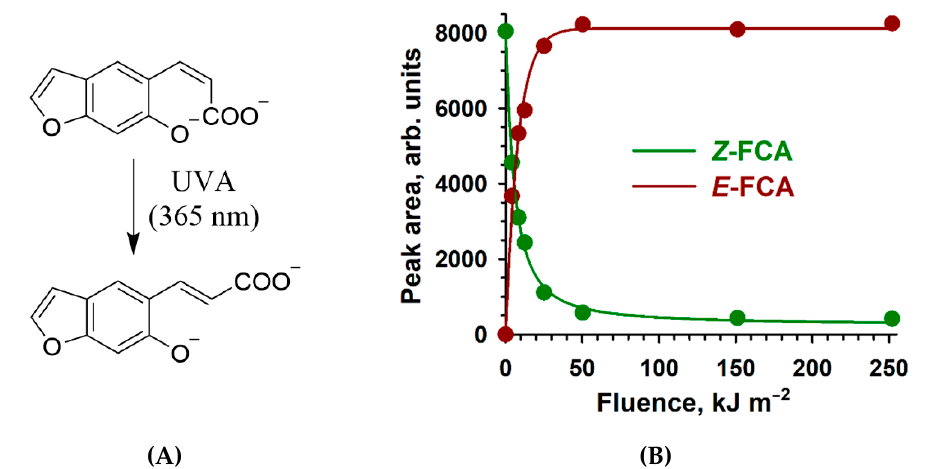
Figure 2. Fluence-dependent HPLC changes during the Z → E photoisomerization process. ( A ) Reaction scheme. ( B ) Z -FCA and E -FCA peak areas as monitored by HPLC. Absorption changes during the Z → E photoisomerization process in alkaline solutions were also fluence-dependent (Figure 3A). After minimal UVA irradiation (4.2 kJ m − 2 ), the Z -FCA dianion absorption maxima at 245 and 343 nm were shifted to 249 and 360 nm, respectively. Upon gradual increase in UVA fluences up to 50.4 kJ m − 2 , the absorption at 249 nm was also increased with a small shift of maximum to 250 nm, while the red shift of the rising 360 nm peak was more pronounced (to 376 nm). At higher fluences, no valuable changes of absorption or peak positions were found. The presence of isobestic points at 240, 314, and 350 nm further implies the Z -FCA dianion conversion to E -FCA dianion.